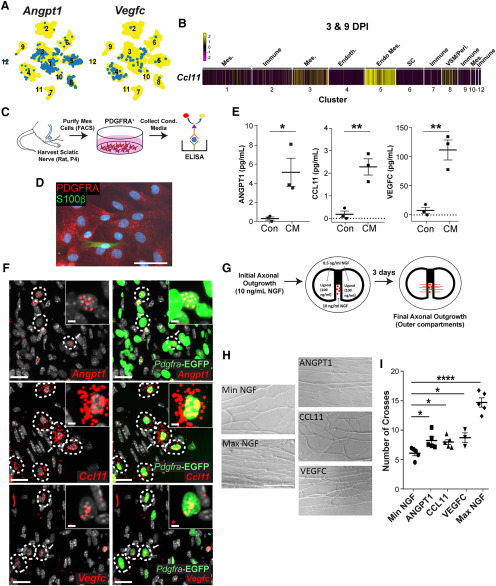
Identification and characterization of ligands expressed in nerve mesenchymal cells that locally promote sympathetic axon growth. A, tSNE gene expression overlays of Angpt1 and Vegfc on the combined 3 and 9 DPI nerve dataset shown in Figure 1E. Cells that detectably express the ligand are colored blue, and the numbers correspond to the clusters. B, Heatmap showing expression of Ccl11 mRNA in single cells within clusters of the combined injured nerve scRNA-seq dataset shown in Figure 1E. Each column line represents the level of expression in a single cell. Gene expression represents scaled expression values using Seurat’s scaling function and is color coded as per the adjacent color key, where yellow indicates the highest expression. Cluster numbers are on the bottom, and the cell types in that cluster are annotated on the top. Mes. = mesenchymal, Endoth. = endothelial, Endo Mes. = endoneurial mesenchymal, SC = Schwann cell. C–E, Neonatal (P4) rat sciatic nerve mesenchymal cells were sorted for cell-surface PDGFRα using FACS, cultured in defined growth medium, and medium was collected after 1–4 d of conditioning. C, Schematic of the experiments. D, Representative image of the mesenchymal cell cultures immunostained for PDGFRα and for the Schwann cell protein S100β to indicate the relative purity of the cultures. Scale bar = 50 μm. E, Quantitative ELISA analysis of the nerve mesenchymal cell conditioned medium for ANGPT1, CCL11, and VEGFC (CM). Control growth medium was used as a negative control in each experiment (Con). Shown are the mean ± SEM from three independent experiments; **p < 0.01 (CCL11, p = 0.0055; VEGFC, p = 0.0045) and *p < 0.05 (ANGPT1, p = 0.031), two-tailed unpaired Student’s t test. F, Images of the 9-d injured distal sciatic nerve of an adult PdgfraEgfp/+ mouse analyzed by FISH for Angpt1, Ccl11, and Vegfc mRNAs. Hatched white lines outline EGFP-positive cells (green nuclei) that were also positive for the mRNA of interest (red dots). Also shown is Hoechst 33258 counterstaining (white/gray) to highlight cell nuclei. The arrows indicate cells that are shown at higher magnification in the insets. Scale bars = 20 μm. Scale bars in insets = 8.75 μm. G, Schematic of the compartmented culture axon outgrowth experiments. Neonatal SCG sympathetic neurons were established in compartmented cultures in the presence of 10 ng/ml NGF. When their axons had crossed into the side compartments, the side compartment medium was replaced with medium containing 0.5 ng/ml NGF plus 100 ng/ml of ANGPT1, CCL11, or VEGFC for three additional days. As a positive control, 50 ng/ml NGF was added into side compartments and as a baseline control, axons were maintained in 0.5 ng/ml NGF alone. H, Brightfield images of sympathetic axons in side compartments grown as described in G, located within 1 mm of the furthest extent of axonal outgrowth. Positive control (Max NGF) = 50 ng/ml, negative control (Min NGF) = 0.5 ng/ml. Scale bar = 100 μm. I, Scatter plots showing the density of outgrowth in response to the different ligands. A vertical line was drawn within the farthest 1 mm of axonal outgrowth, and the number of axons crossing the line was quantified. A maximum of eight separate lanes was scored per technical replicate, with three to four technical replicate cultures (i.e., cultures generated from sympathetic ganglia harvested from the same litter) scored per biological replicate (n values in plot). Individual points show mean ± SEM of individual biological replicates; *p < 0.05 (p = 0.041), ****p < 0.0001, one-way ANOVA with Holm–Sidak’s multiple comparison’s test (n = 5 for all treatments except VEGFC, where n = 3).